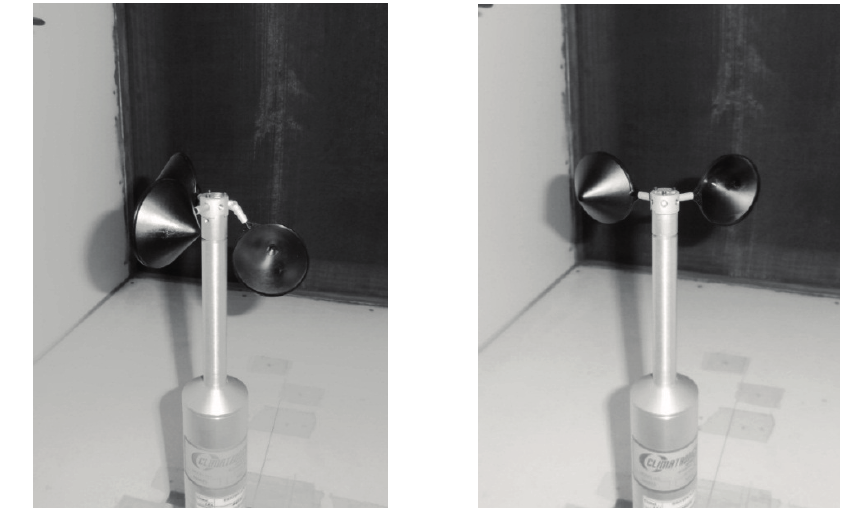
Figure 16. Climatronics 100075 cup anemometer equipped with two damaged rotors: Damaged cup-arm rotor ( Left ) and 1-missing-cup rotor ( Right ).